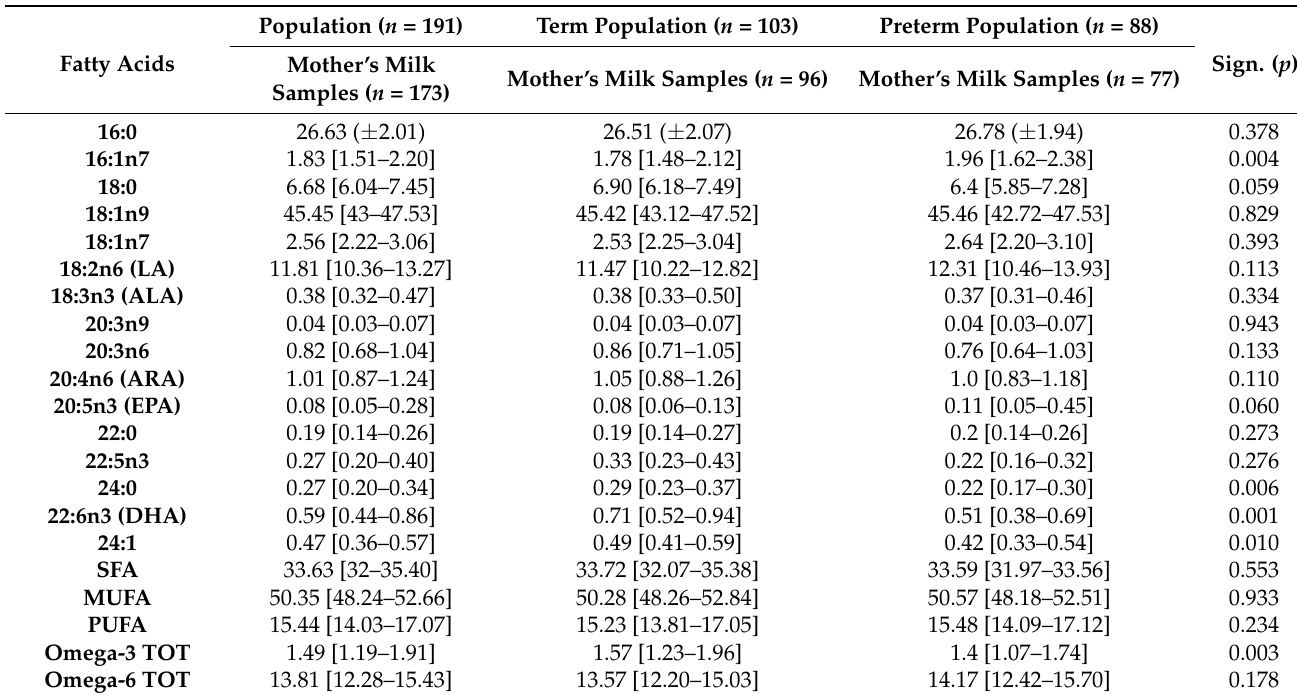
Table 2. Fatty acid composition of mother’s milk. The fatty acid levels are expressed as a percentage of the total fatty acid concentration, (g DHA/100 g of total fatty acids = % FA). p -values: from t -test between preterm vs. at term population. Data are expressed as mean ± SD or median